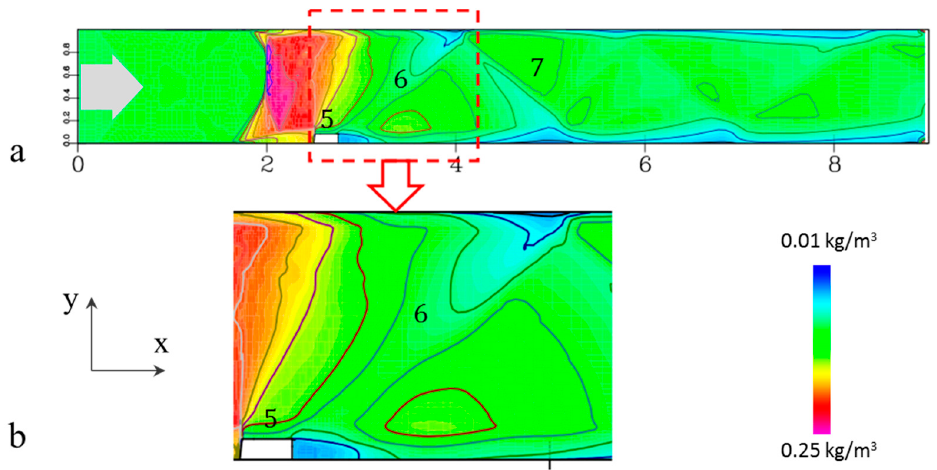
Figure 8. Simulated flow density field ( a ) and the enlarged fragment ( b ). The flow Mach number is 1.40. Designations (numbers) as in Figure 1.